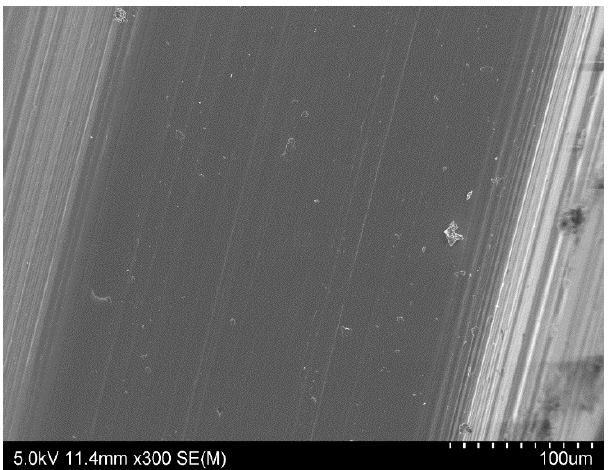
Figure 5. SEM image of a rough machined surface of the Biomet 3i OSSEOTITE ® implant: Magnification ×300.